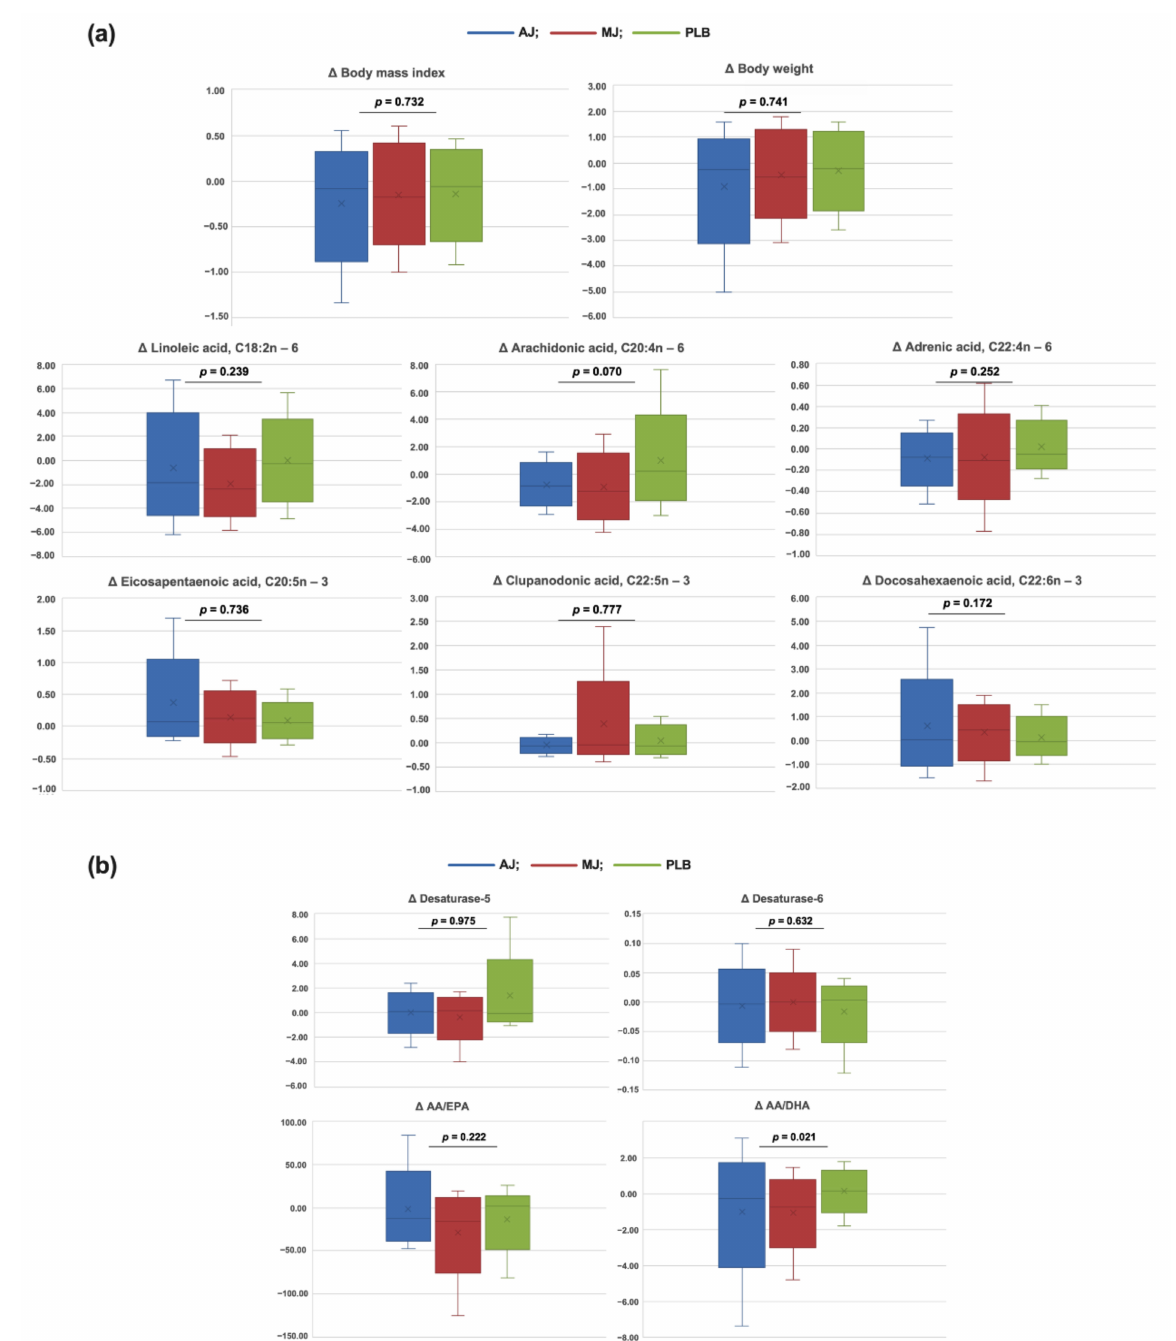
( p for interaction = 0.063, Figure 2a,b). Again, only in subjects drinking AJ, the rs174576 gene-effects tended to affect the link between changes in EPA with BMI and weight gain ( p = 0.067 for both).